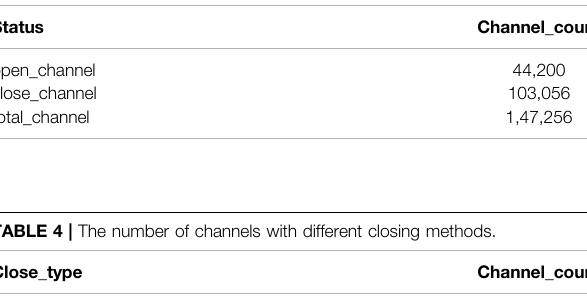
TABLE 3 | The number of channels opened and closed.